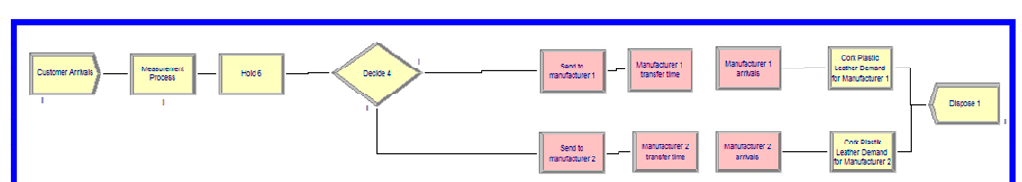
Figure 7. Customer arrivals to the orthopedist.